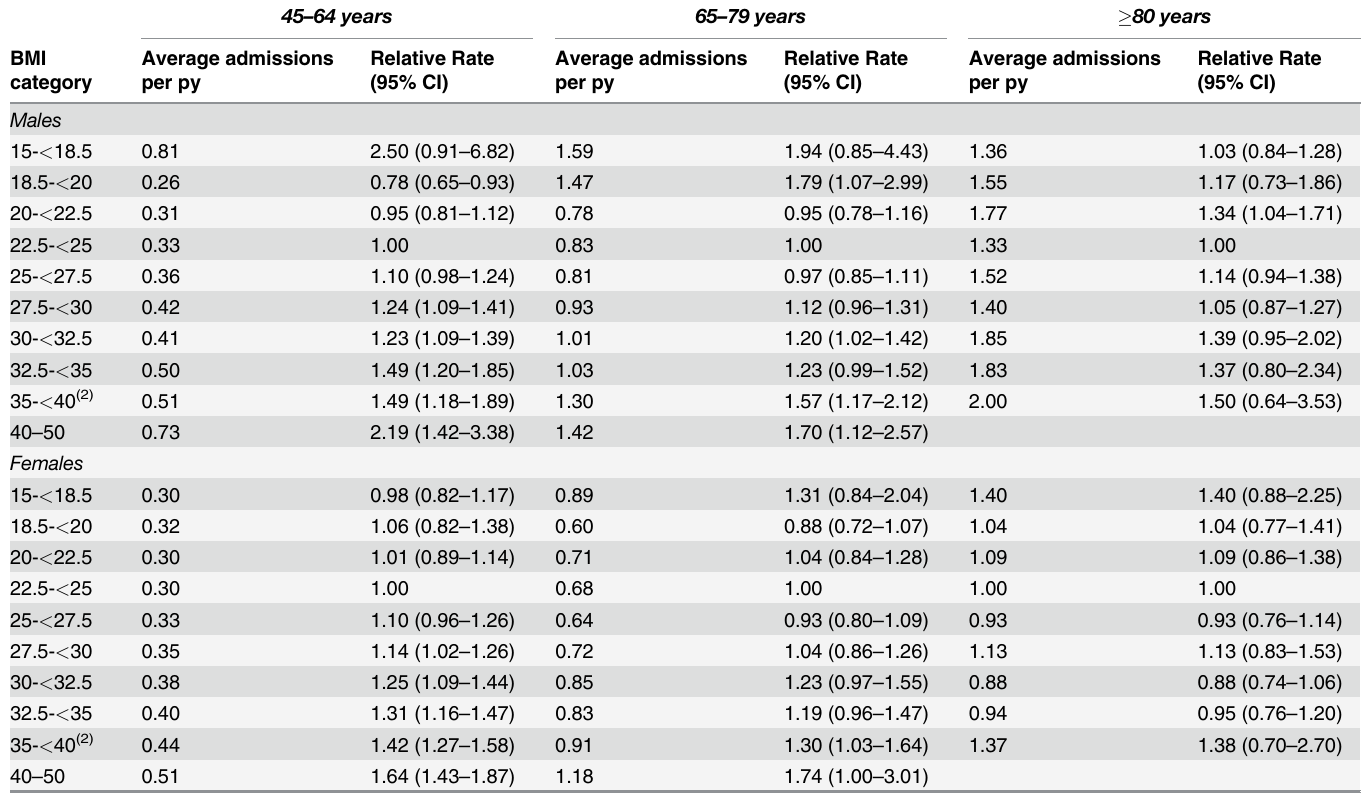
Table 2. Estimated hospital admission rates by body mass index (BMI) (1)